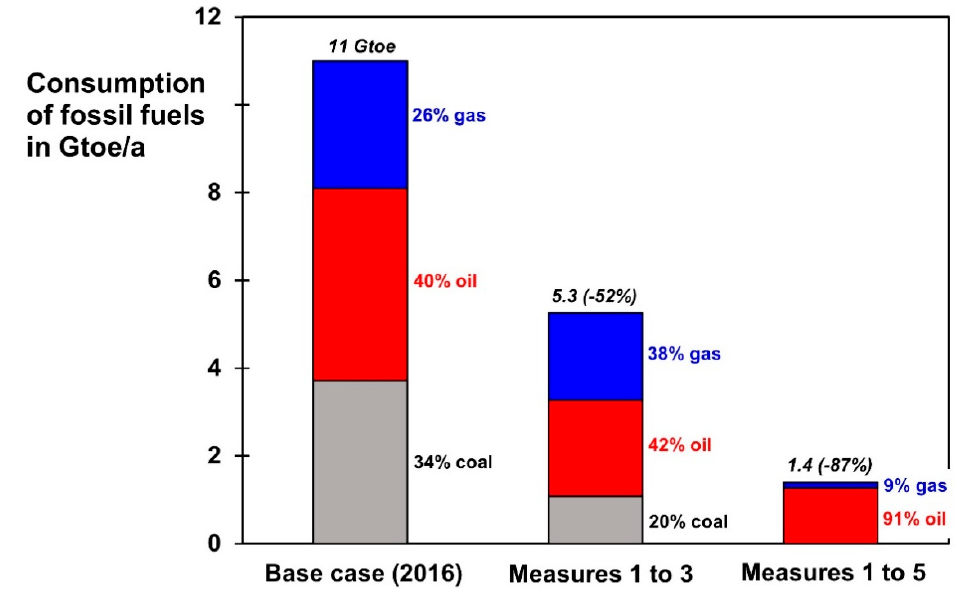
Figure 7. Global consumption of fossil fuels (coal, oil, gas) in the base case (2016) and if consecutive measures 1 to 3 or 1 to 5 are taken (constant global population and prosperity). For the measures 1 to 5 the residual oil demand (1.3 Gtoe) is the result of non-energetic use (52%) and the production of jet-fuel and fuel for shipping (48%).